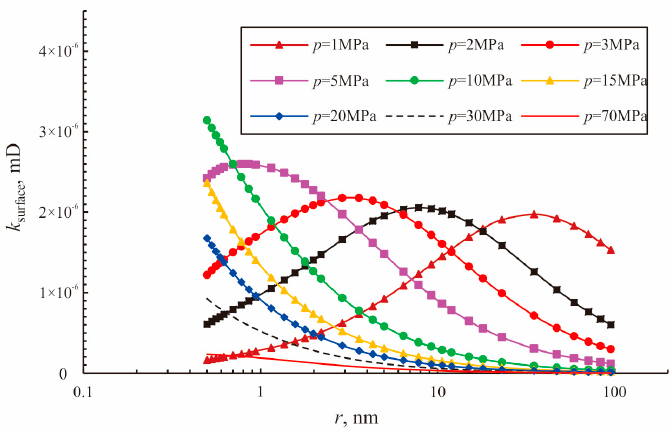
Figure 13. Equivalent permeability of surface diffusion in different conditions.